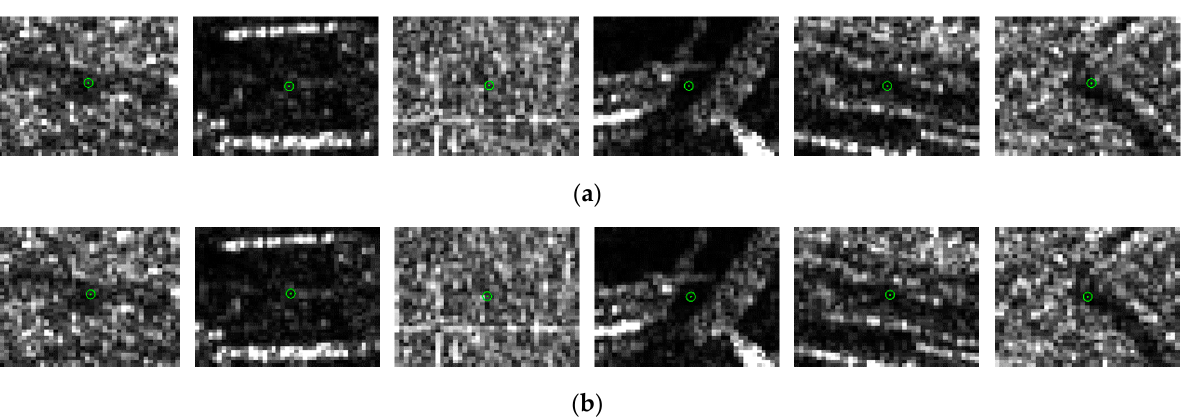
Figure 9. Comparison of six pairs of randomly selected tie-points in the strip and their SAR images, where ( a ) is the master image and ( b ) is the slave image.